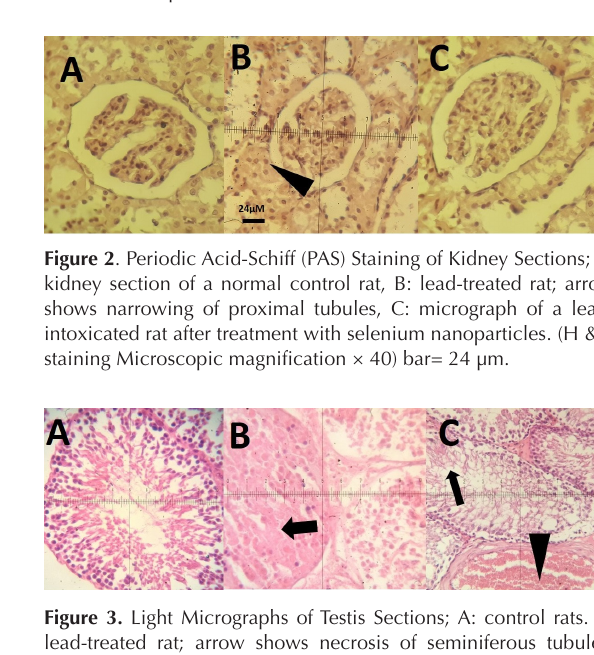
Figure 1 . Light Micrograph of a Liver Section of Experimental Groups; A: Liver section of a normal control rat, B: liver section of a lead-treated rat; arrow shows disarrangement of hepatic cords, C: liver micrograph of a lead-intoxicated rat after treatment with CeNPs. (Periodic acid–Schiff staining microscopic magnification. × 40) bar= 24 µm.